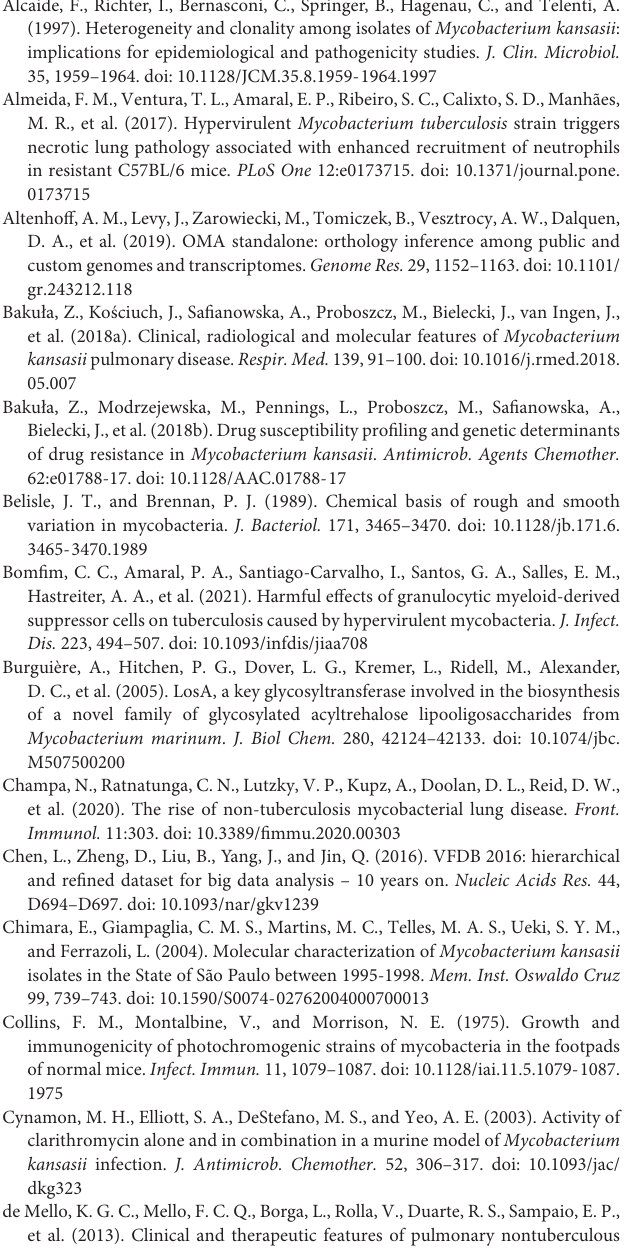
(A) The numbers of CFU recovered from macrophages infected at a MOI of 1:1 were quantified at days 1 and 4 p.i. The bacterial growth rate is presented as mean ± SD of increases in the log 10 numbers of intracellular CFU measured in two separate experiments. (B) Induction of necrotic cell death in the cell cultures infected at a MOI of 10:1. LDH release from the dead cells was measured in the culture supernatants at day 3 p.i., and the percentage of cytotoxicity was calculated as described in “Materials and Methods” section. Asterisks indicate the isolates for which the values of growth or cytotoxicity differed significantly from the respective value of the reference ATCC 12478 strain; ∗ P < 0.05; ∗∗ P < 0.01; ∗∗∗ P < 0.001.